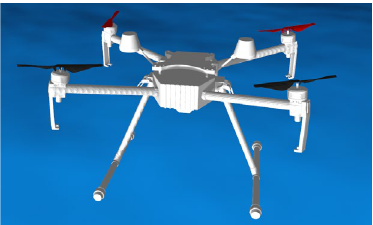
Figure 4. Modeled DJI M210 in virtual environment.